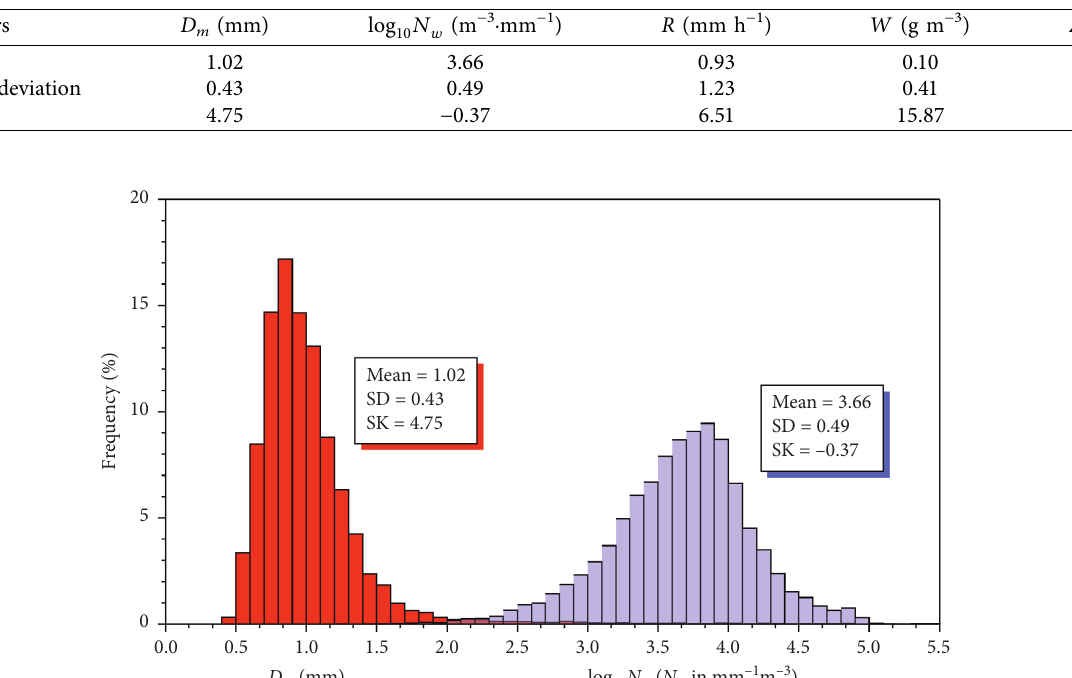
Figure 2: Frequency distribution of rain rates calculated from the disdrometer Table 1: Statistics of DSD parameters for all observations.